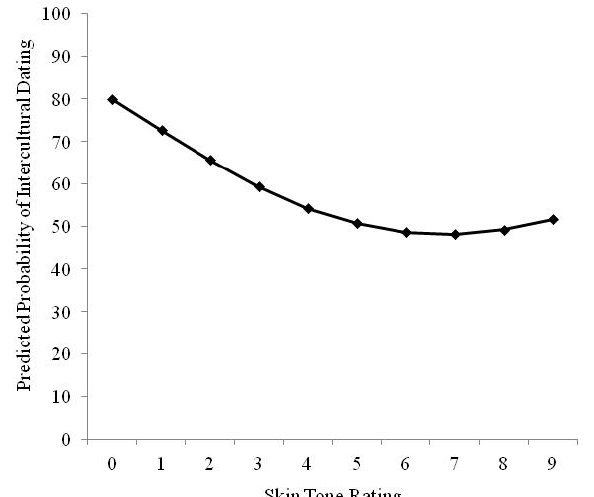
Note: Predicted probabilities are adjusted for all covariates shown in Table